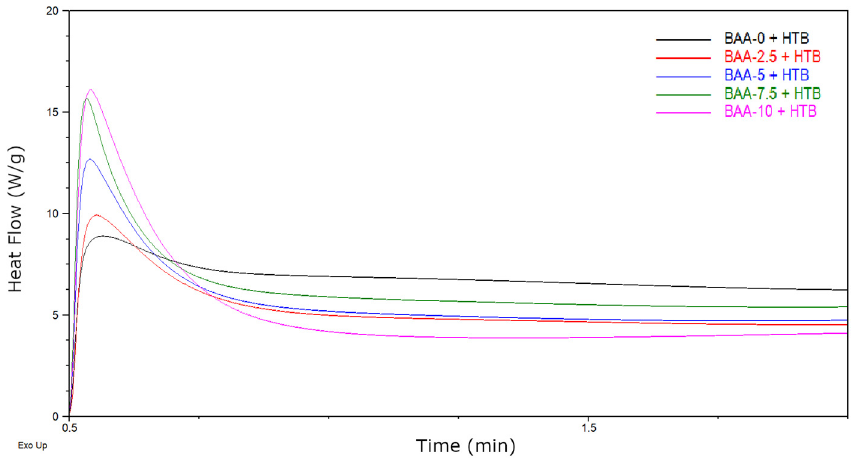
Figure 5. Photo-DSC curves of adhesive compositions (I 0 = 500 mW / cm 2 ; 230–390 nm).